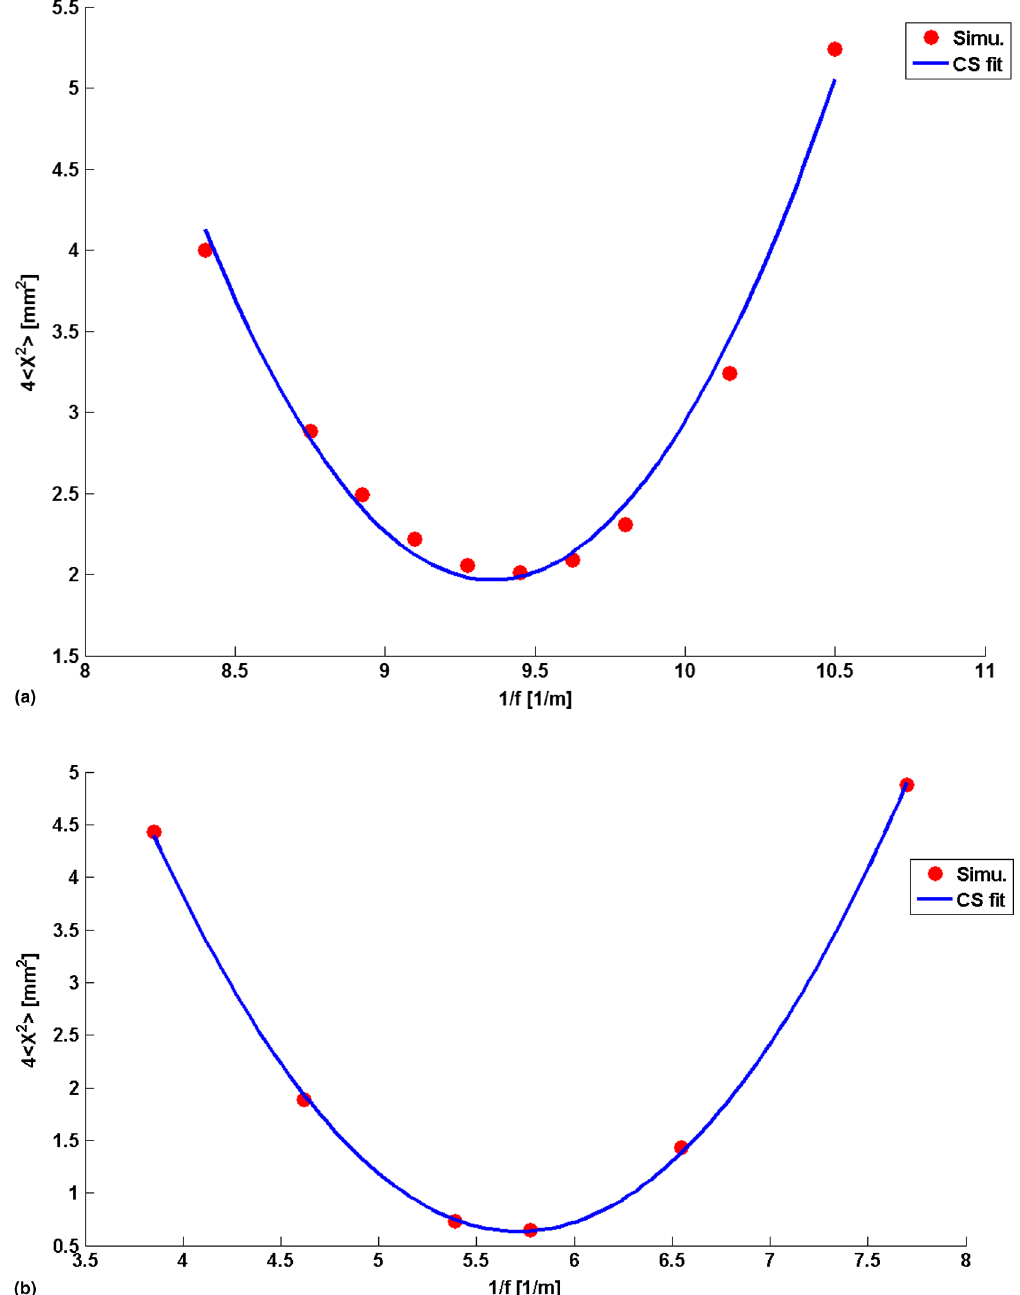
FIG. 5. Plot showing quadrupole radius scan for (a) beam with high space charge ( K ¼ 7 : 06 (cid:3) 10 (cid:1) 4 ) and (b) emittance-dominated beam ( K ¼ 7 : 35 (cid:3) 10 (cid:1) 6 ). The blue curve is a quadratic fit to the simulated data samples shown with red circles. The goodness-of-fit parameter is 0.95 for case (a) and 0.999 for case